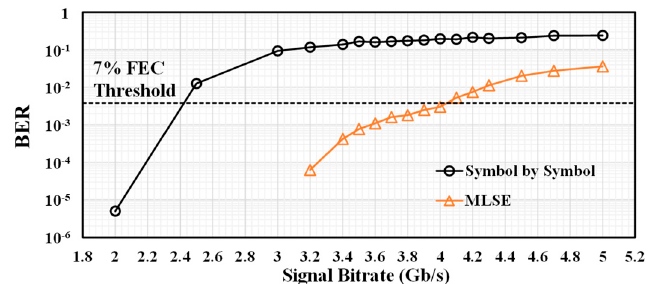
Figure 7. BER vs. signal bitrate using symbol by symbol detection and 7-tap MLSE detection.